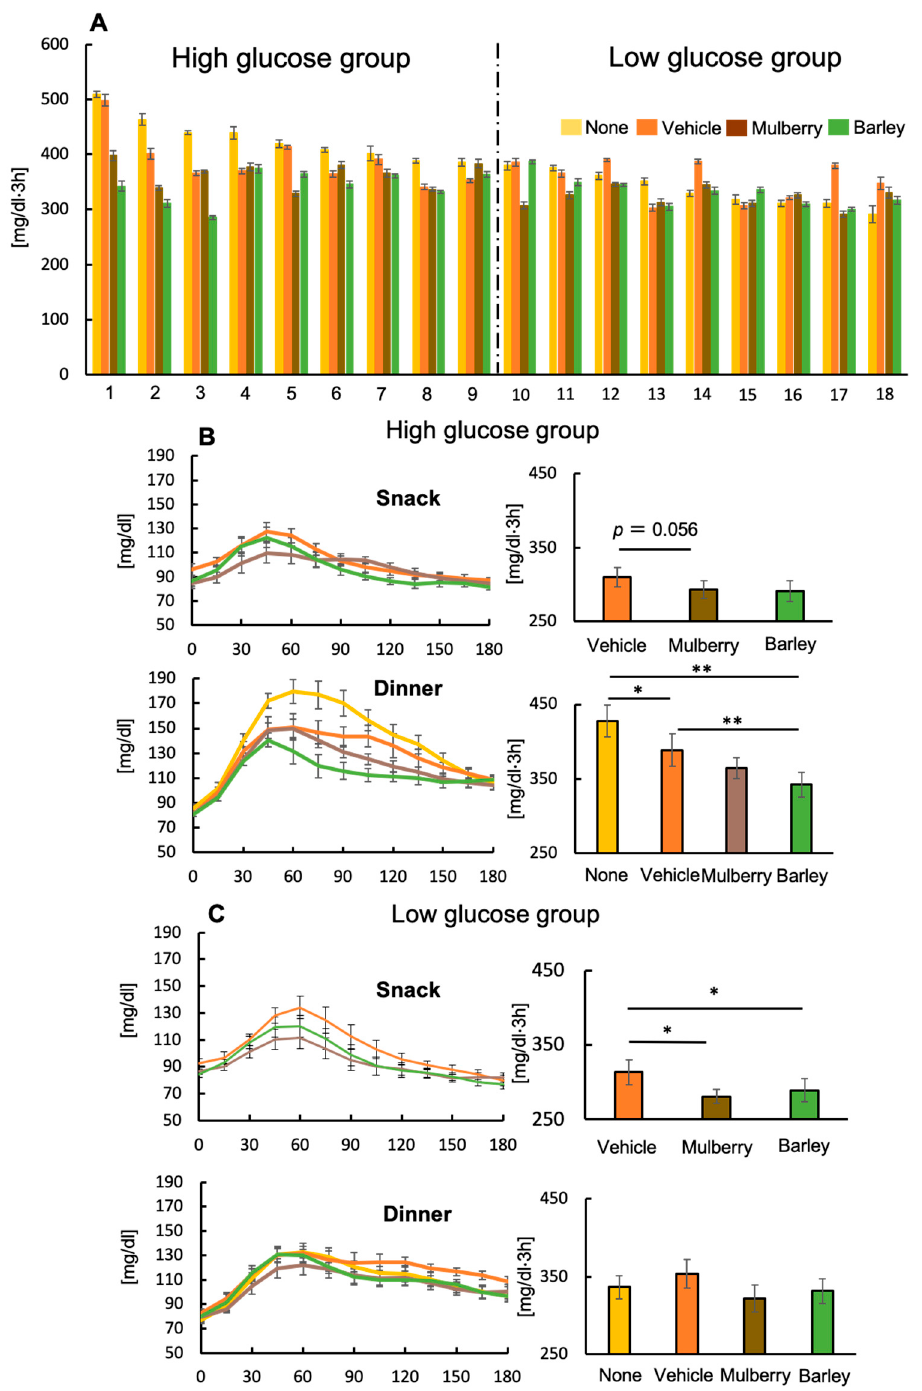
Figure 4. Changes in glucose levels for the high- and low-glucose groups. Area under the curve (AUC) of glucose levels after dinner for the none group ( A ), changes in glucose levels and AUC after consuming the snack and dinner for the high-glucose group ( B ), changes in glucose levels and AUC after consuming the snack and dinner for the low-glucose group ( C ). Values are means and standard errors. * p < 0.05, ** p < 0.01.